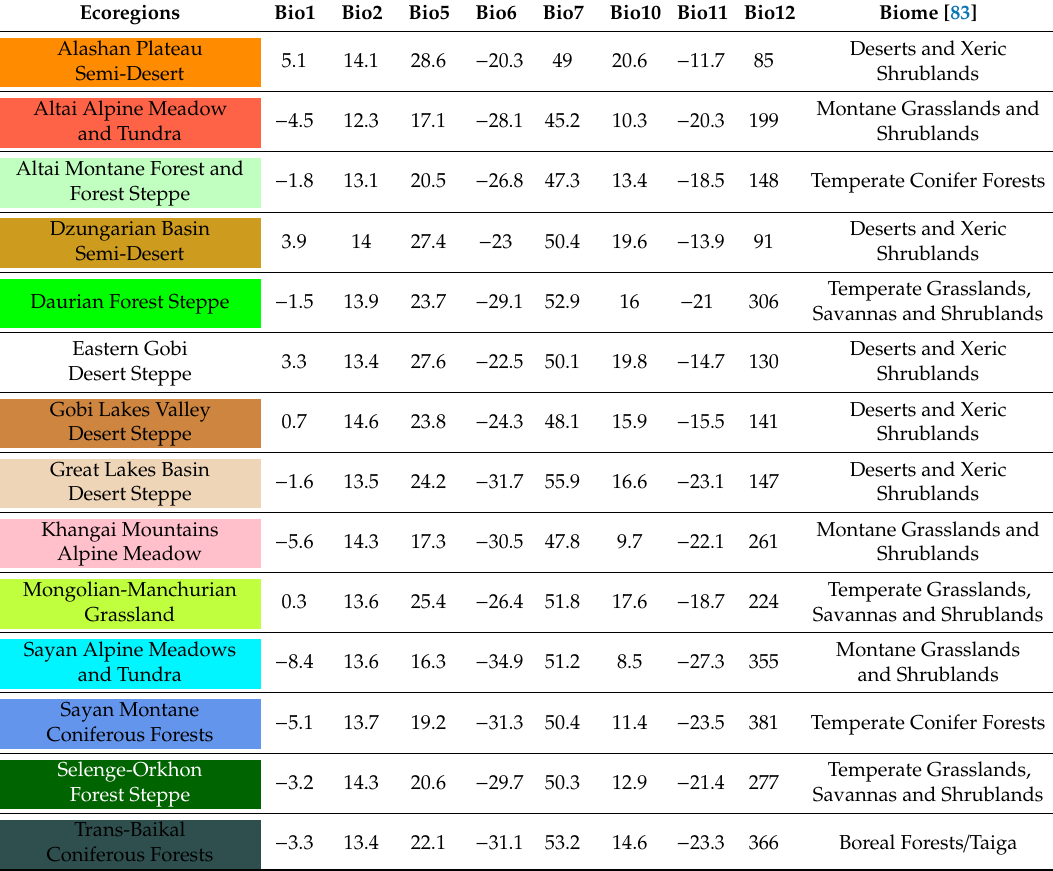
Table 1. List of the environmental [79] variables* for the fourteen ecoregions used in this study. All variables have been entered into forward selection method for selecting most important variables. The selected variables were later fitted in the Non-Metric Multidimensional Scaling Analysis (NMDS). Colors refer to the map in Figure